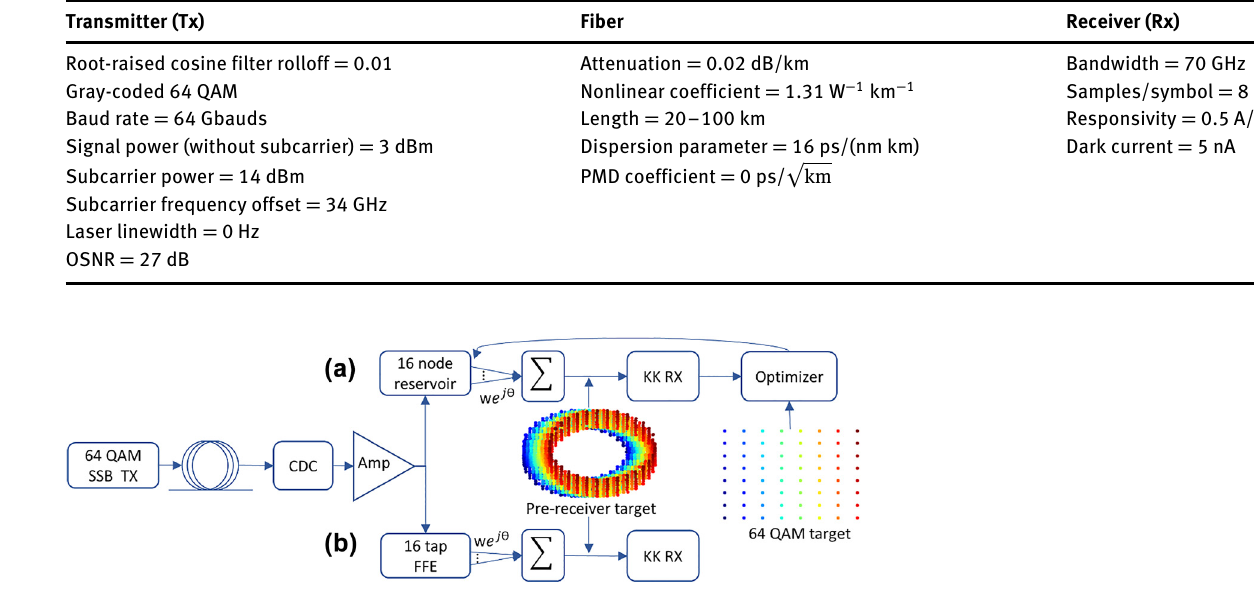
Figure 5: Simulation setup generating high intensity 64-QAM signals passed through fiber links that are dispersion compensated, nonlinearity equalization to take place in: (a) 16 node reservoir with complex readout weights found linearly and through backpropagation; or (b) 16 tap feed forward equalizer with complex weights found linearly. Acronyms–SSB Tx, single-sideband transmitter; CDC, chromatic dispersion compensation; Amp, amplifier; KK RX, Kramers–Kronig receiver; wej θ , complex weight with amplitude w and phase 𝜃